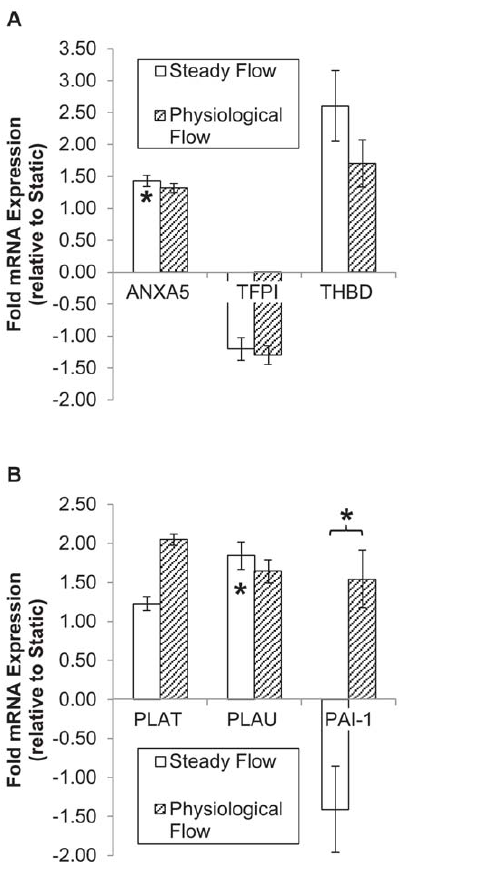
Figure 5. Coagulation & fibrinolysis-associated gene expres- sion in flow-conditioned endothelial cells. Shown is fold mRNA expression (with respect to static-cultured EC) of genes associated with hemostasis (A) and fibrinolysis (B). Results are presented as mean 6 SEM. An embedded asterisk indicates a significant difference with respect to static controls; an asterisk over a bracket indicates a significant difference between flow groups. Abbreviations: ANXA5 : annexin V; TFPI : tissue factor pathway inhibitor; THBD : thrombomodulin; PLAT : tissue plasminogen activator; PLAU : urokinase plasminogen activator; PAI-1 : plasminogen activator inhibitor-1.